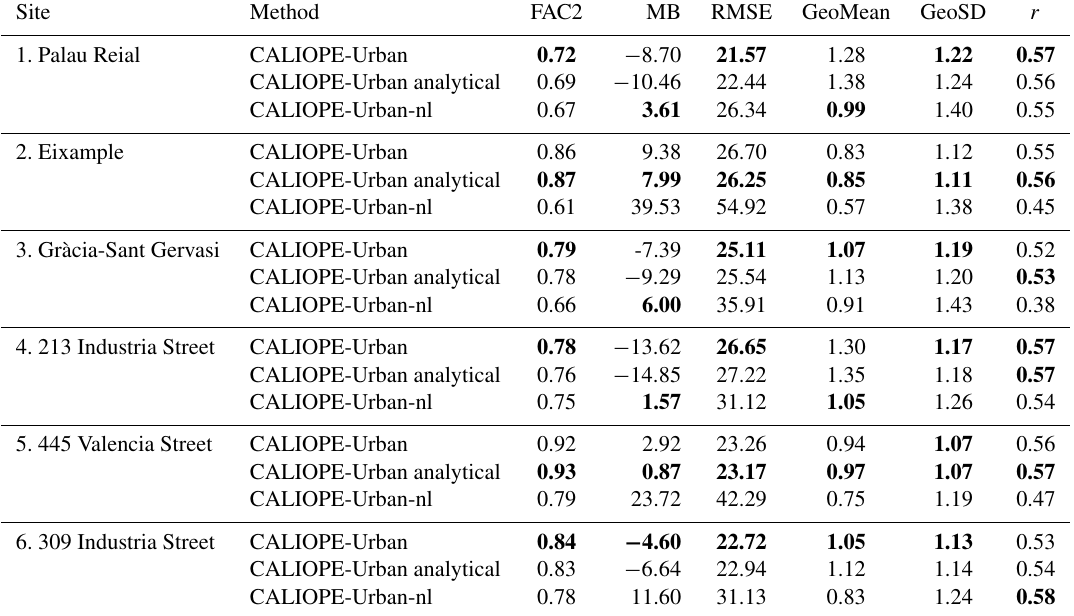
Table B2. NO 2 model evaluation statistics calculated at six sites (described in Sect. 3) during April and May 2013 for hourly concentrations of CALIOPE-Urban, CALIOPE-Urban analytical or CALIOPE-Urban-nl (non-local) configurations. Bold numbers represent model results with better performance for each statistic and